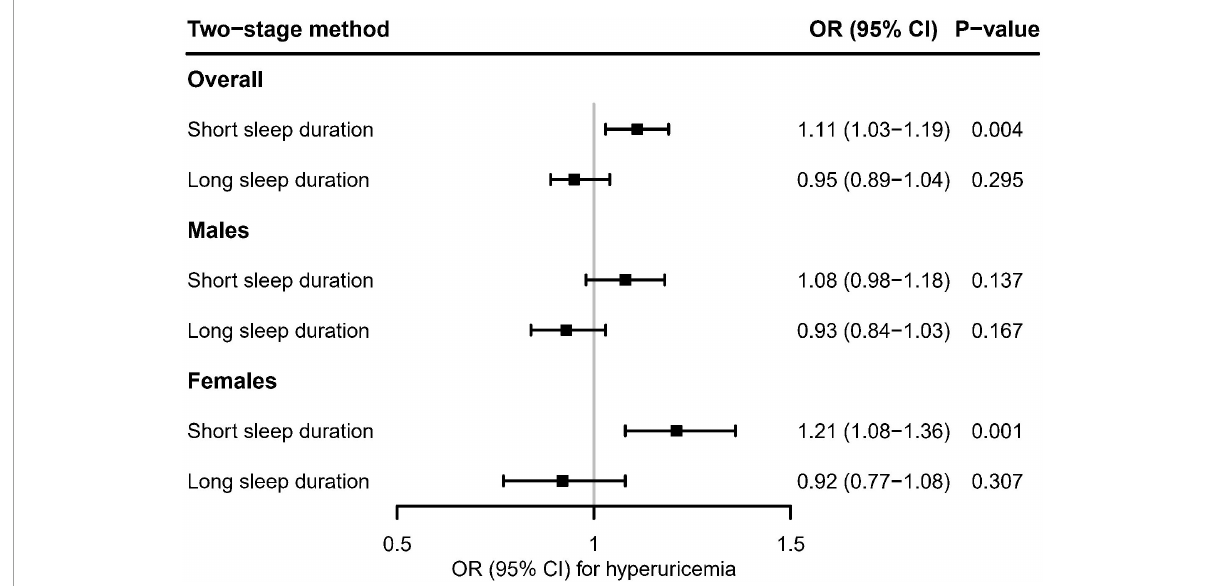
FIGURE5 Using the two-stage method, mendelian randomization estimates for genetically predicted short and long sleep duration with hyperuricemia in the UK Biobank. After correcting for multiple comparisons, P < 0.05/6 = 0.008 was considered significant.